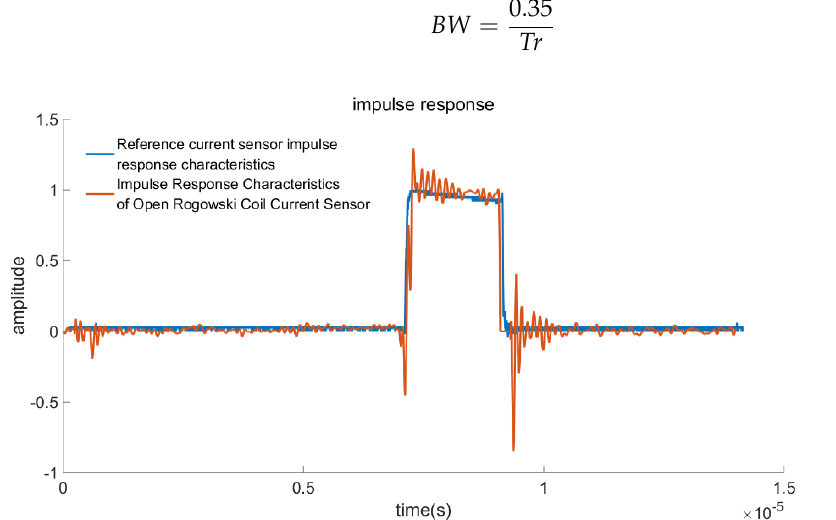
Figure 19. Response diagram of sensor pulse signal.